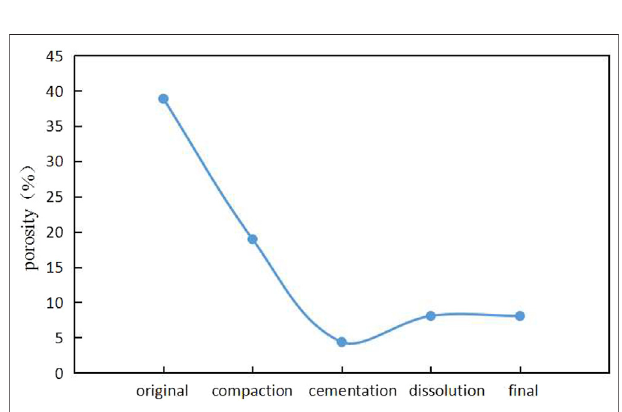
FIGURE 9 | Pore evolution of Chang 8 reservoir in the study